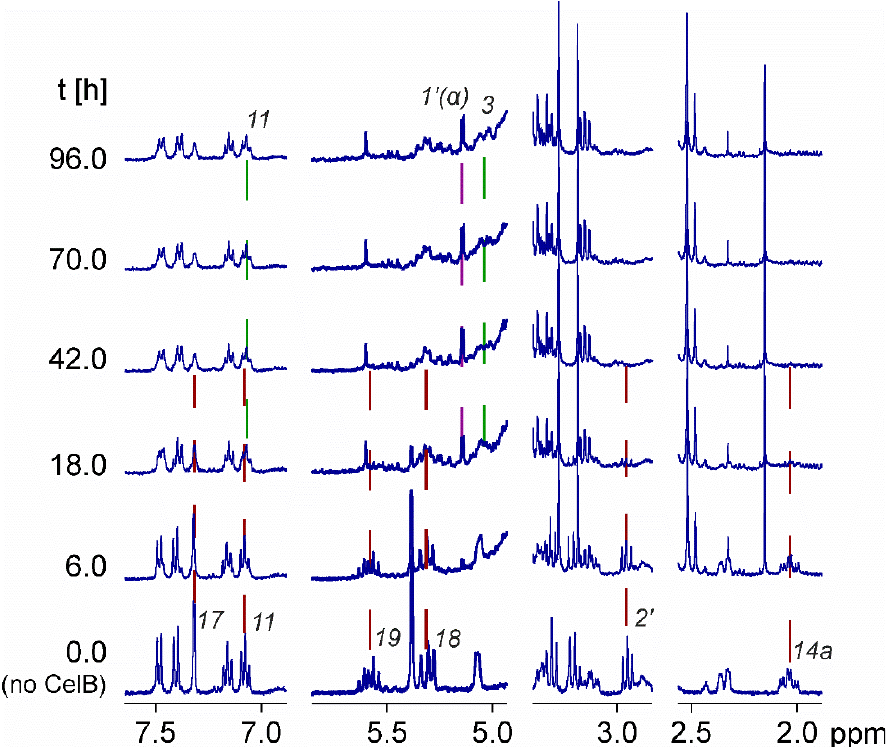
Figure 4. In situ 1 H NMR spectra of the enzymatic deglucosylation of strictosamide ( 1 ) by β -glucosidase (CelB) in (10% DMSO- d 6 /D 2 O (pD 6.4) 1:9) [24–26]. Shown are the spectrum of 1 without CelB at 0.0 h and five spectra measured during the course of the reaction. Signals of H-11, H-14a, H-17, H-18, and H-2’ of strictosamide ( 1 ) are numbered in the spectrum recorded at 0.0 h and indicated with a red dashed line to indicate degradation by hydrolysis. Concomitant new signals of accumulated products arose. Some of those are numbered in the spectrum recorded after 96.0 h and indicated with green and pink dashed lines, respectively. The signal indicated violet belongs to the anomeric signal of the α -anomer of the released glucose. The signals indicated in green belong to protons of compound 1a . In particular, the signal of H-11 is well detectable. However, signals of some other protons appear much smaller than they should be, for example the signal from H-3. This is due to wash in of deuterium into this product, caused by equilibria between various tautomeric forms as earlier described for other compounds possessing keto